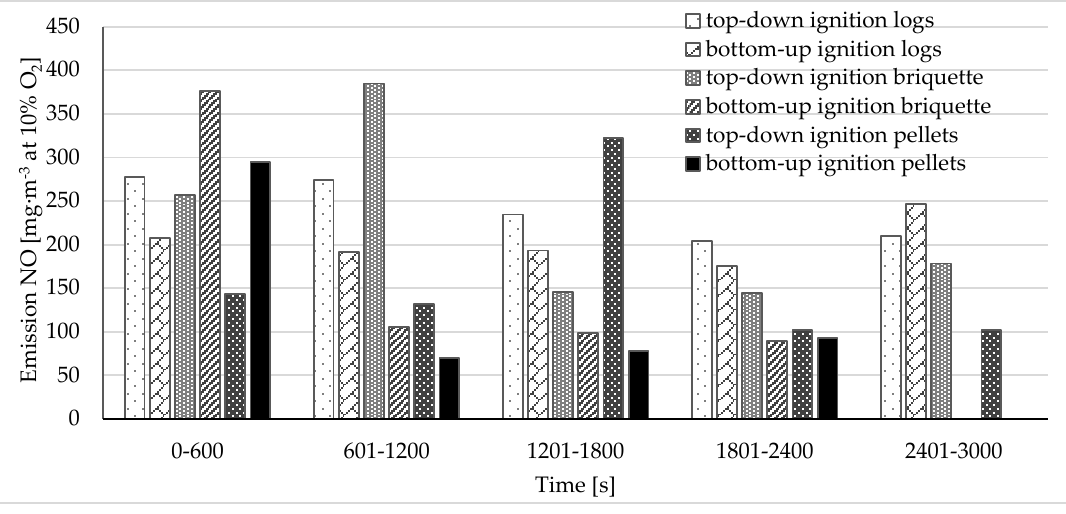
Figure 7. Changes in nitric oxide emission during the combustion of the selected biomass forms (average values for separate combustion phases and ignition techniques).